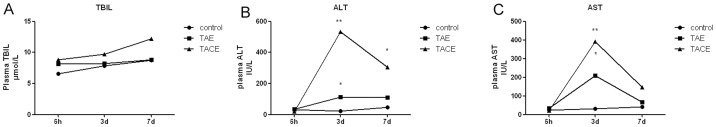
Postoperative changes in serum ALT, AST and bilirubin levels.(A and B) ALT and AST peaked on day 3 in the TAE and TACE groups. (C) Serum bilirubin levels increased slightly after all of the procedures, but these increases were not significant. *P<0.05 compared to the control group; **P<0.05 compared to the TAE and control groups.